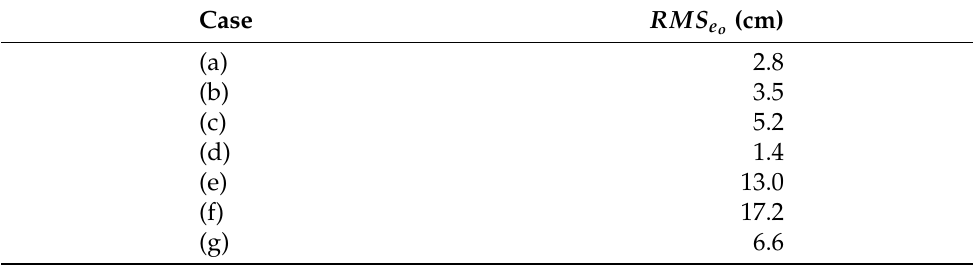
Figure 10. Variation of the inputs and output of the PFC corresponding to the test cases explained in Figure 9. It should be noted that the Y-axis corresponding to ω is on right side of each plot. The corresponding test cases are indicated by the subfigures as follows: ( a ) The robot was placed with no heading error with the perimeter wall. ( b ) The robot was placed with an inward heading error. ( c ) The robot was placed with an outward heading error. ( d ) A segment with more objects to be traverse. ( e ) A segment with an inward slanting perimeter. ( f ) A segment with an outward slanting perimeter. ( g ) A segment with an inward and outward slanted perimeter. Table 3. Root mean square of e o ( RMS e ) for the test o